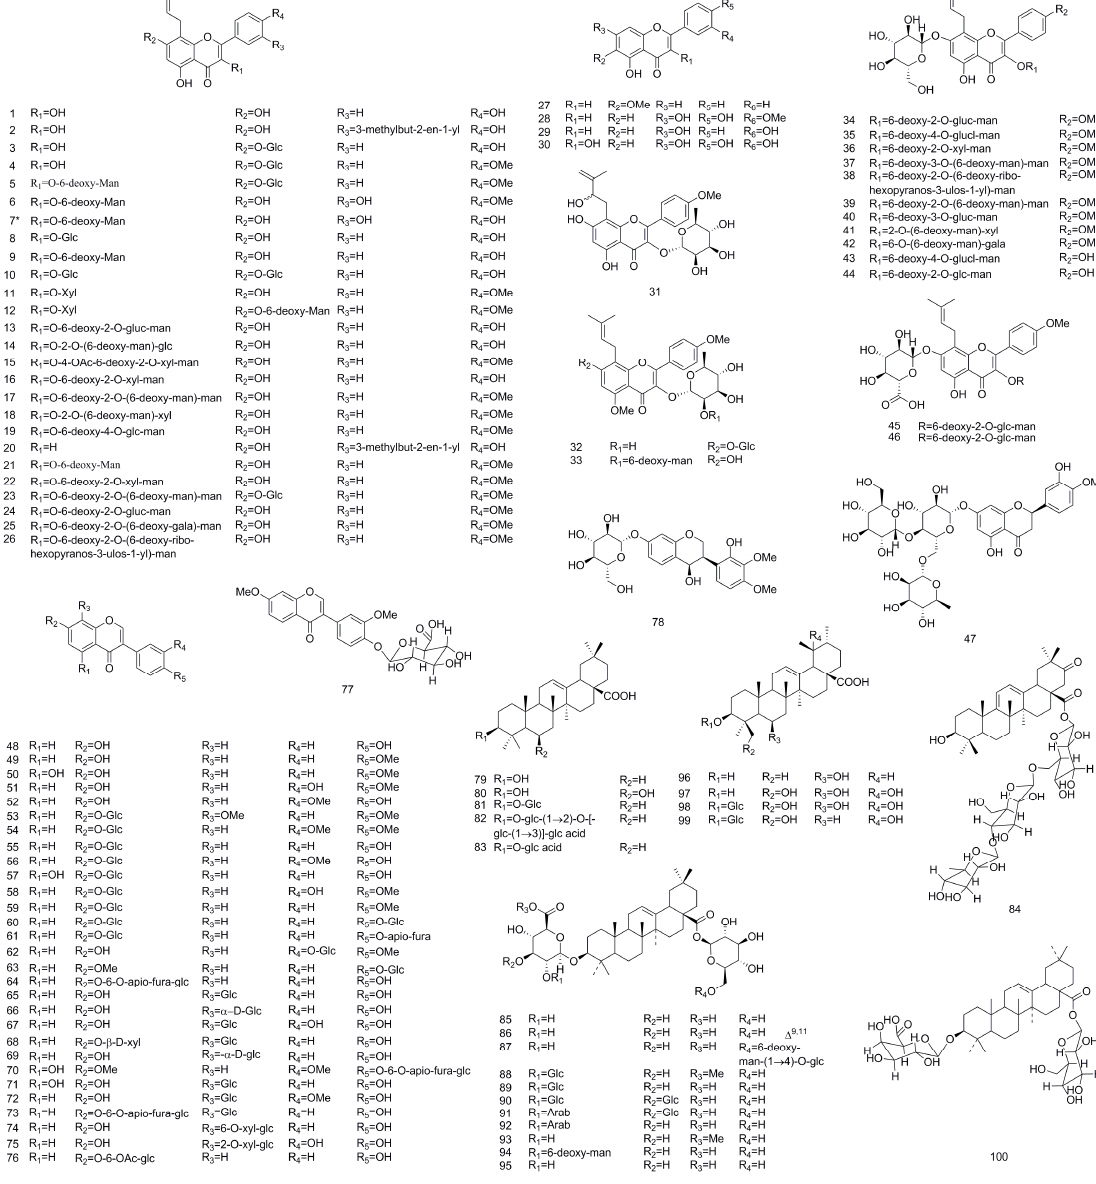
Figure 1. Structures of compounds 1 – 100 isolated from Jing liqueur.